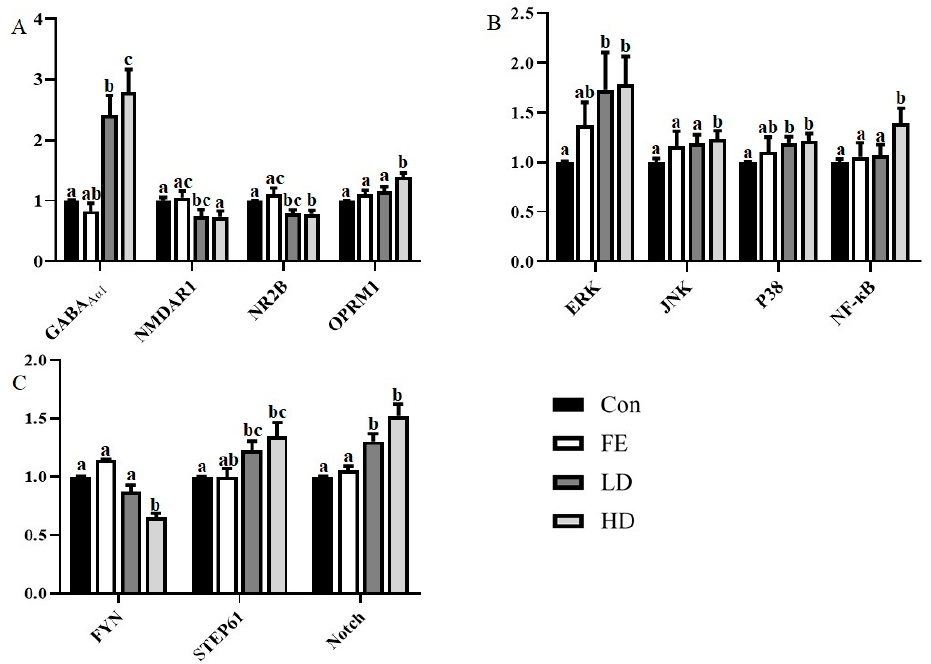
Figure 1. The messenger RNA (mRNA) expression of related genes encoding ion channels and receptor related proteins ( A ), coding transcription factor-related genes ( B ), and other cytokines ( C ). Different colors are used to indicate the different processing methods. β -actin was used as the reference gene for normalization, and the difference was calculated with STATISTICAL ANALYSIS SYSTEM (SAS). Superscripts with different letters indicate significant differences ( p < 0.05).